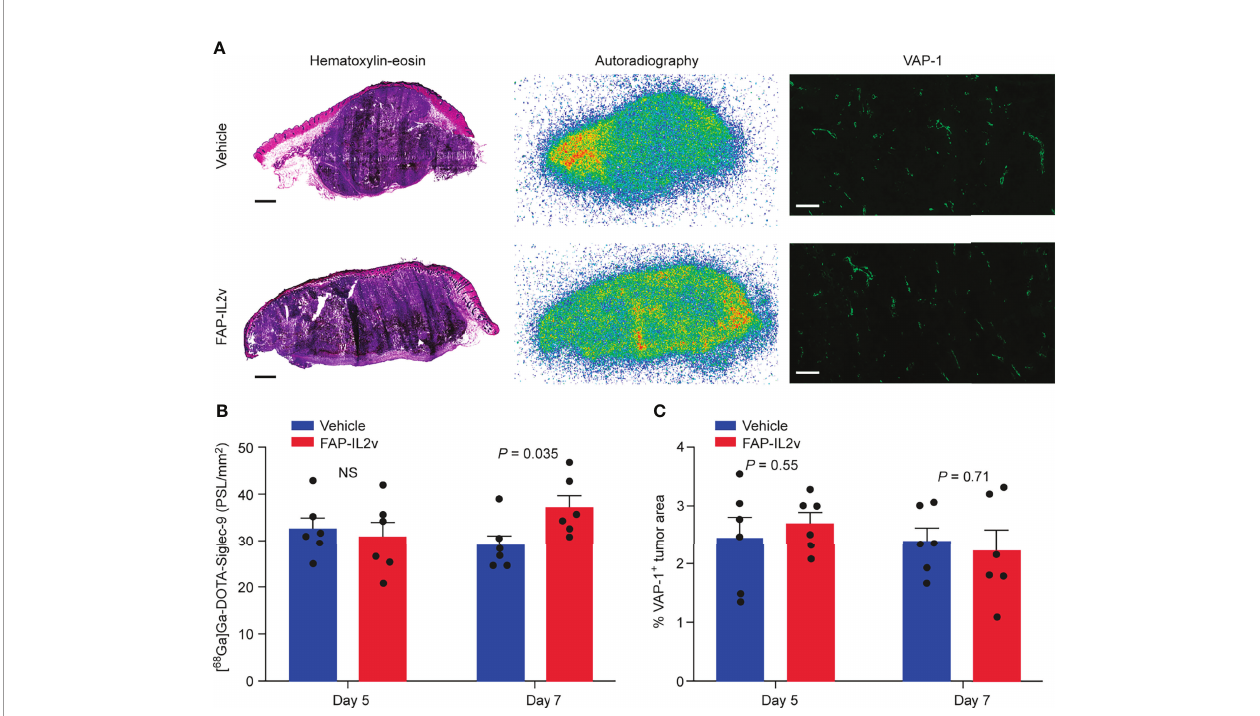
FIGURE 3 | Autoradiography of [ 68 Ga]Ga-DOTA-Siglec-9 in B16-FAP tumors. (A) Representative B16-FAP tumor sections stained with hematoxylin-eosin (HE), the corresponding autoradiographs and vascular adhesion protein-1 (VAP-1) immuno fl uorescence staining from mice treated with an IL-2 variant fused to fi broblast activation protein (FAP-IL2v), and vehicle-treated mice 7 days after baseline imaging. The scale bar is 1 mm for the HE-stained image and 200 µm for VAP-1 staining. (B) Quanti fi cation of tumor autoradiographs showing the distribution of [ 68 Ga]Ga-DOTA-Siglec-9 in FAP-IL2v-treated and vehicle-treated mice ( n = 6/group/ timepoint). Results are expressed as photostimulated luminescence per square millimeter (PSL/mm2). NS, not signi fi cant. (C) The area of VAP-1-positive blood vessels from B16-FAP tumors ( n =